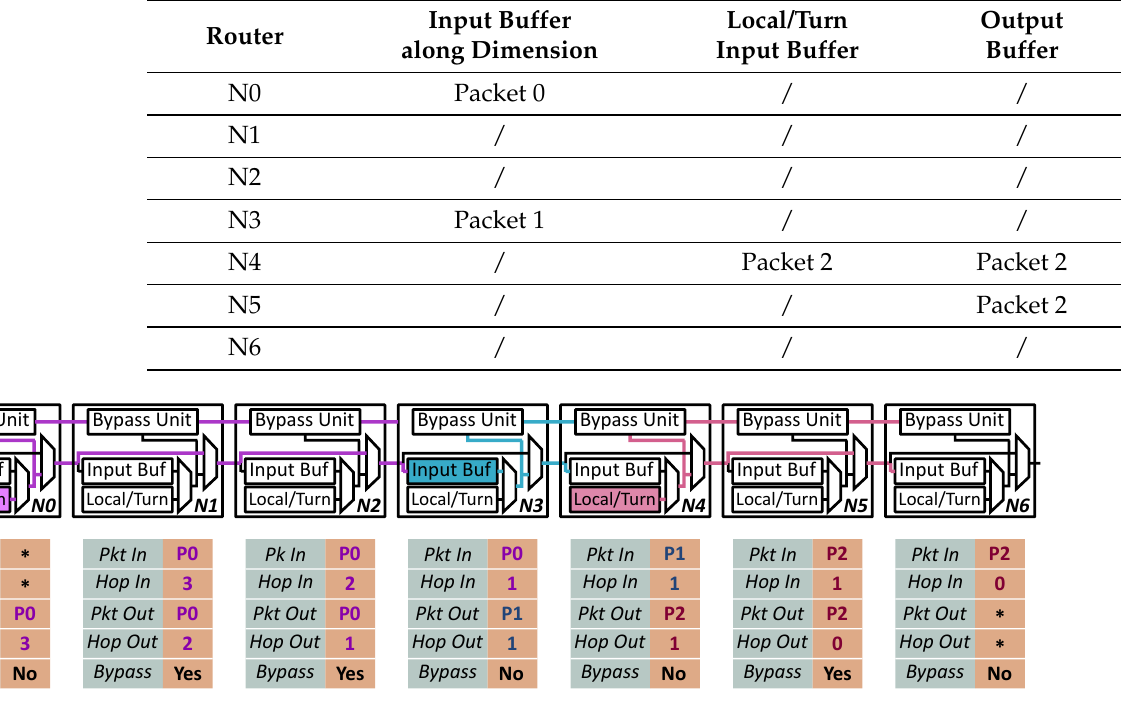
Table 1. The status of all routers.